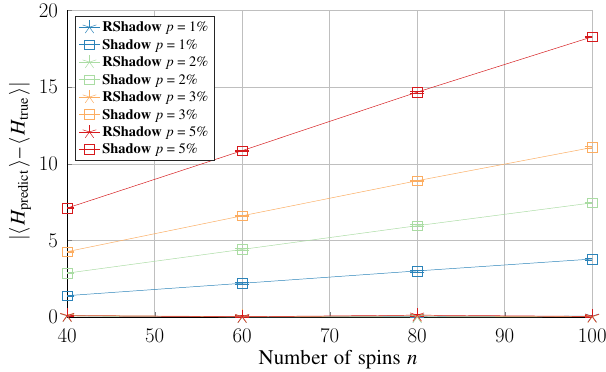
FIG. 6. Energy expectation estimation on a 1D TFIM ground state for different numbers of spins and different bit-flip